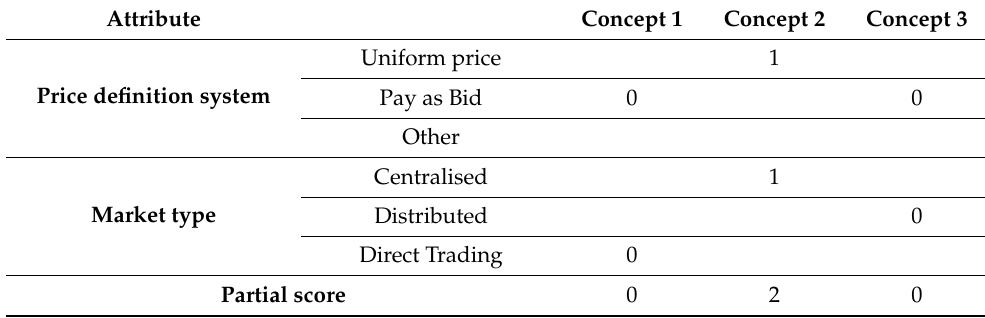
Table 13. Entry barrier—second partial score. Price mechanism and market type attributes.